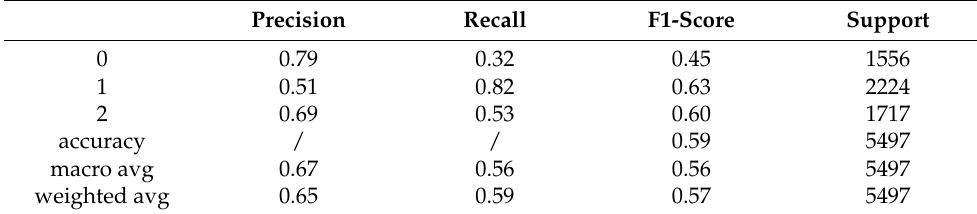
Figure 6. Jenks break clustering for sentiment analysis. Table 4. Clustering with TextBlob classification_report.